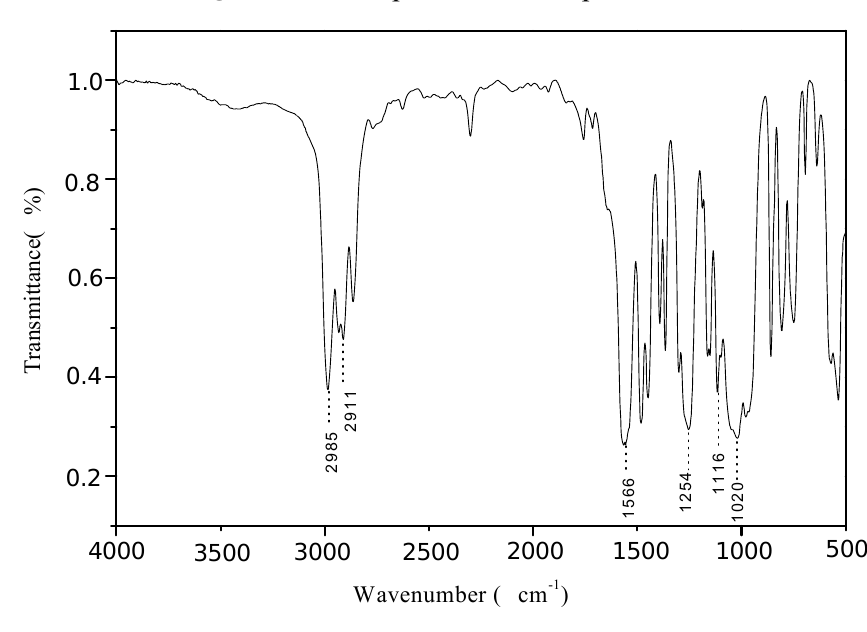
Figure 2. FTIR spectrum of compound 2.